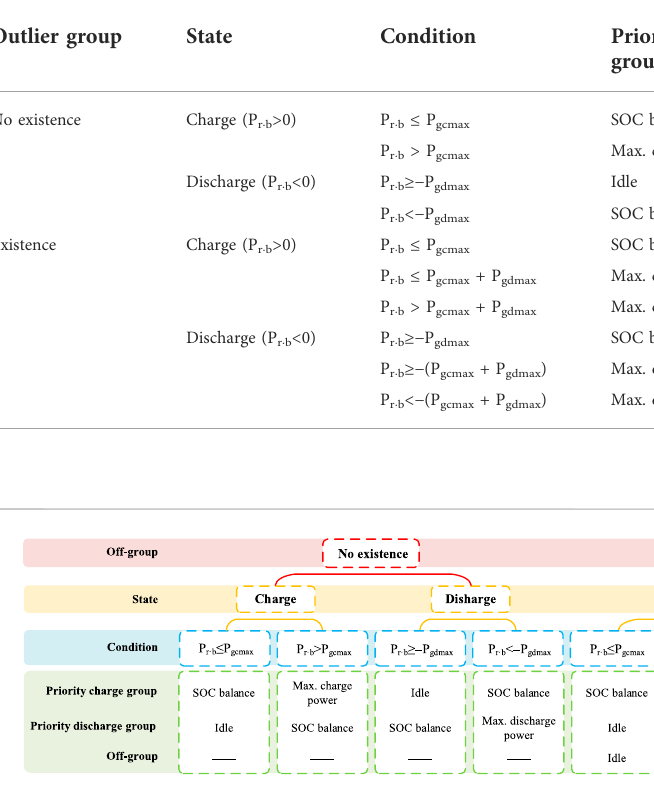
TABLE 2 Power distribution principle for battery units in each battery group with different states.